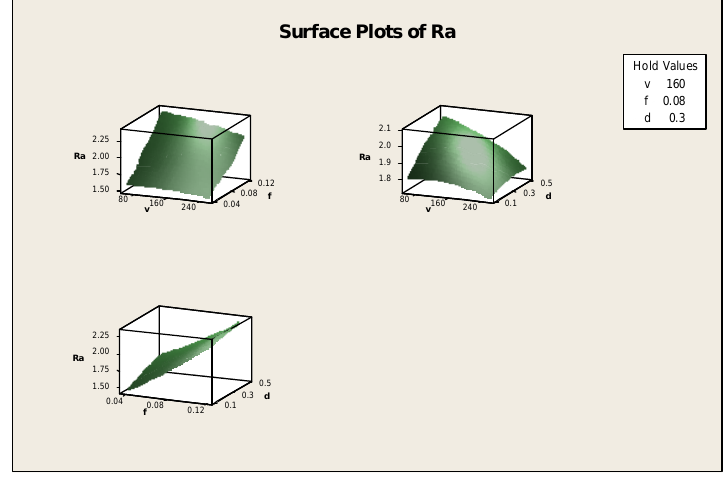
Fig. 7. Surface plots of